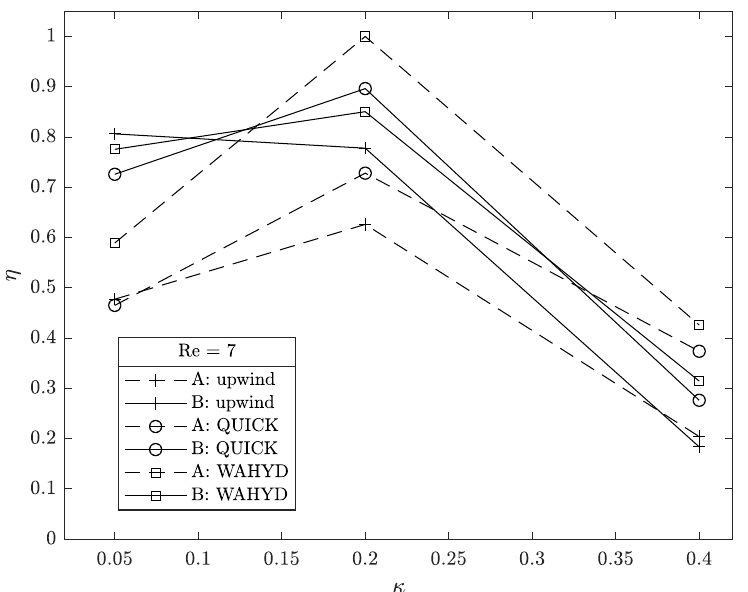
Figure 32. Computational efficiency as function of κ for the flow around a cylinder case with Re = 7 using the E grid.